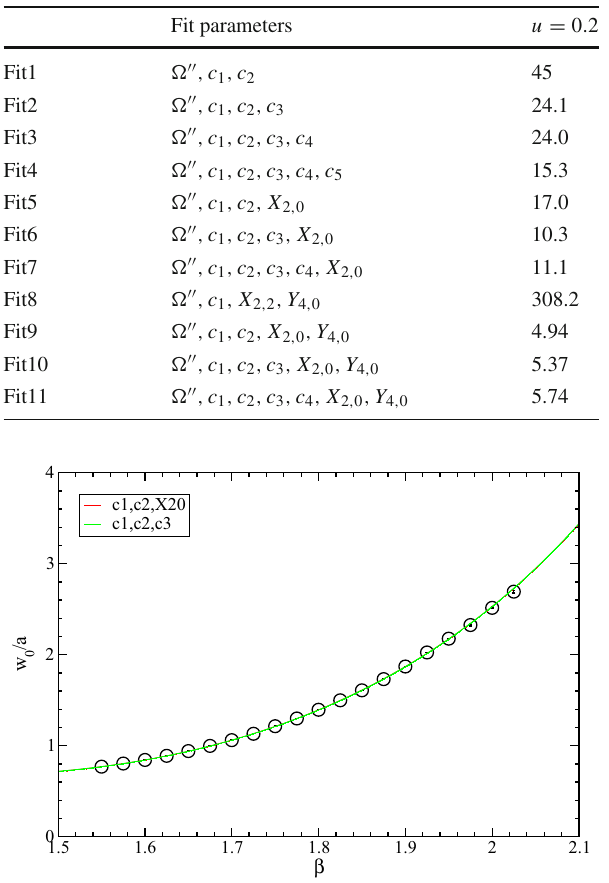
Table 5 Summary of χ 2 / d.o.f. for different types of fits of ˆ t 0 versus β .